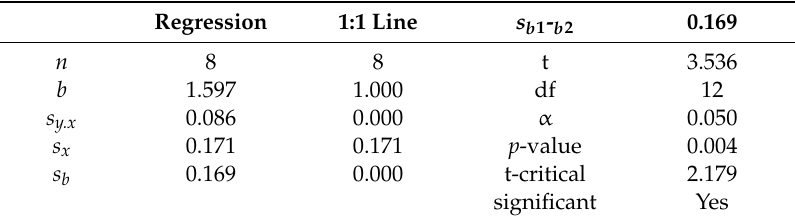
Table A2. Comparison of prediction line and 1:1